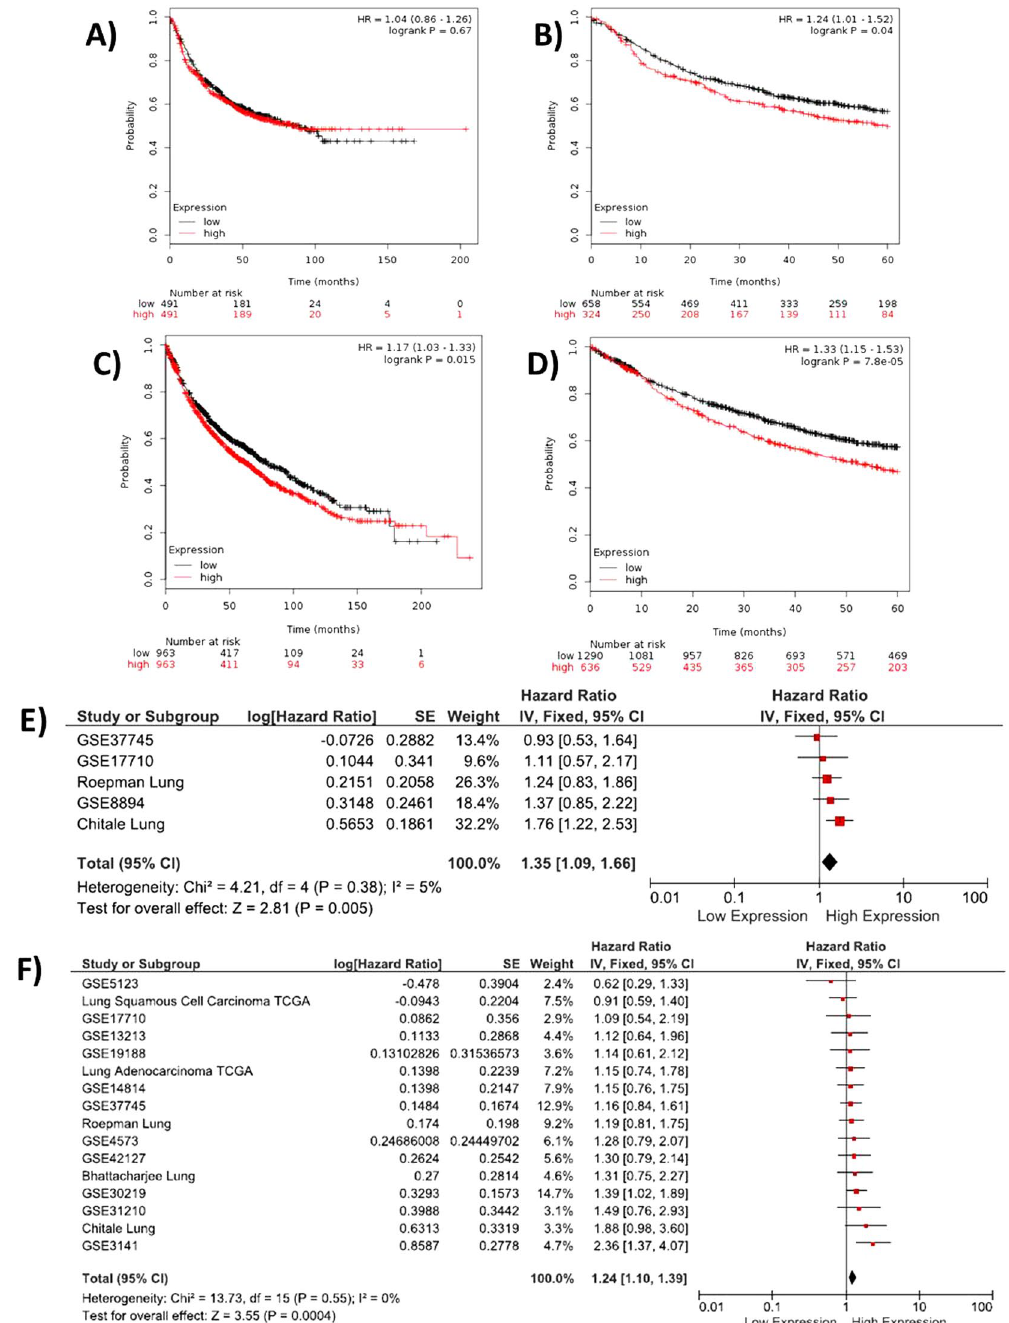
Figure 5. Analysis of pooled datasets of lung cancer. ( A ) Evaluation in KM-plotter shows that DDIT4 expression (cutoff over the median) is not related with the free progression time; however ( B ) in 5-years censored data stratified in the upper tertile, high DDIT4 expression is related with PF [N = 982; P = 0.04] ( C ) Overall survival analysis show that DDIt4 expression over the median is related with a poor outcome (P = 0.015), ( D ) increasing the significance when data is 5-years censored and stratified by the upper tertile. Meta-analysis in SurvExpress show DDIT4 expression over the median increases the ( E ) risk of recurrence by 35% and ( F ) the risk of death by